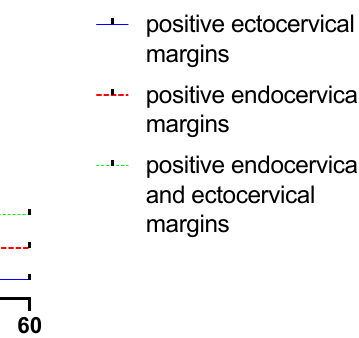
Figure 3. Nomogram assessing the risk of cervical dysplasia persistence/recurrence. Table S1 displays details of the logistic model. Table S2 displays the impact of varia- bles in predicting the risk of cervical dysplasia persistence/recurrence. Table S3 reports the risk of recurrence according to the proposed model. 3.3. Validation Cohort The validation cohort included 549 patients treated between 1 January 2015 and 30 June 2016. As for the primary cohort, all women included had undergone conization for high-grade cervical dysplasia and achieved a 5-year follow-up. Overall, 38 (6.9%) patients experienced recurrence. Table S4 reports baseline characteristics of the validation cohort. Using data from the validation, we observed a C-index of 0.809. Accuracy of the model was 0.7304 (95%CI: 0.6912, 0.7671). Sensitivity, specificity, positive predictive value, and negative predictive value were 0.7436, 0.5526, 0.9572, and 0.1382, respectively. Figures S4 and S5 show diagnostic accuracy and the ability to predict for cervical dysplasia persis- tence/recurrence, respectively.